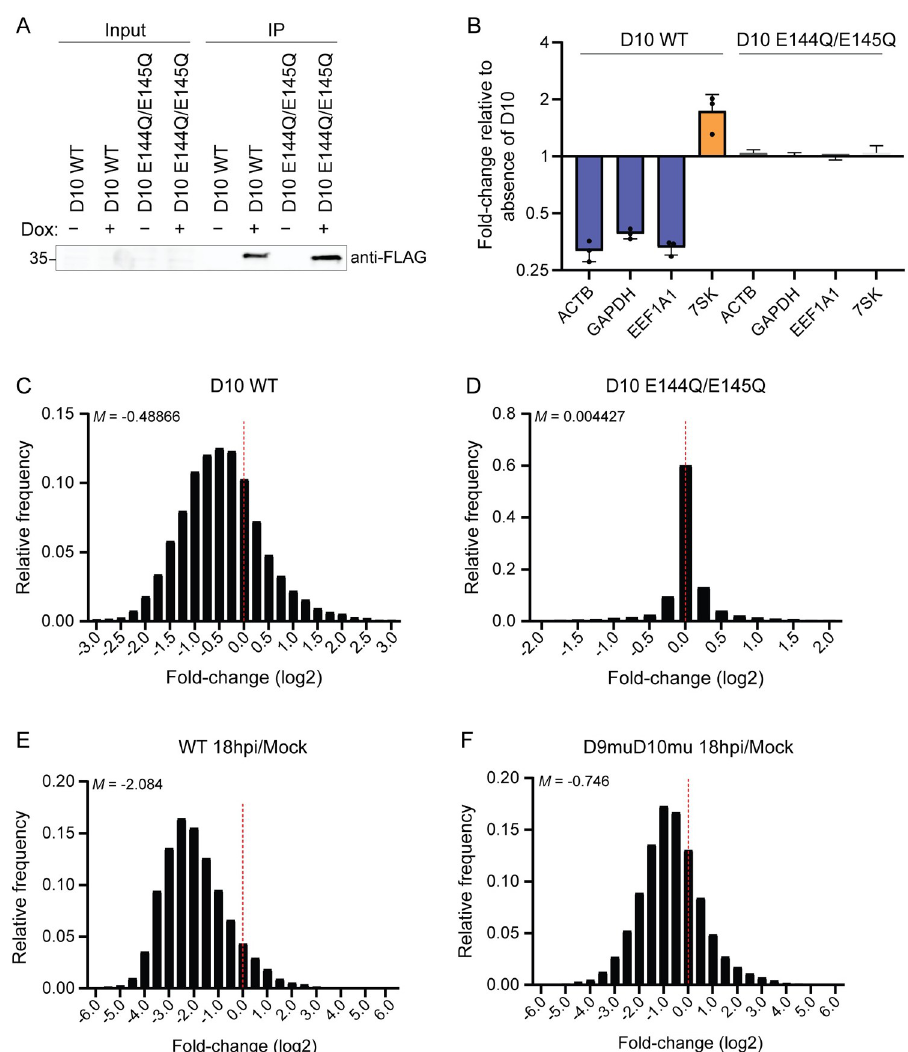
Fig 1. VACV D10 causes global mRNA degradation. (A) Levels of 3xFLAG-D10 WT and E144Q/E145Q were visualized by western blotting following immunoprecipitation with anti-FLAG beads. (B) RT-qPCR was used to measure levels of the indicated RNAs in either uninduced (-) or dox-induced (+) 3xFLAG-D10 WT and E144Q/E145Q HEK293T stable cells. Each point represents an independent replicate (N = 3). The bars represent the mean value of the replicates and error bars represent standard deviation. (C-D) The fold-change value for each host transcript in the 3xFLAG-D10 WT ( C ) and E144Q/E145Q ( D ) was calculated by dividing its expression in the dox-treated condition by its expression in the untreated condition. The frequency distribution for these values is plotted on each histogram. The dotted red line marks the fold-change value of zero, and the median value ( M ) is shown for each plot. (E-F) The fold- change value for each host transcript was calculated by dividing its expression at 18 hpi with either WT VACV ( E ) or D9muD10mu VACV ( F ) by its expression in mock infected cells. The frequency distribution for these values is plotted on each histogram. The dotted red line marks the fold-change value of zero, and the median value ( M ) is shown for each plot. total reads at 18 hpi, consistent with the role of mRNA degradation in shifting the host tran- scriptome to one that is dominated by viral transcripts during infection (S2D Fig). GO term enrichment analyses indicated that, in the D10 induced and WT VACV infection contexts, the most downregulated transcripts included genes involved in oxidative phosphory- lation, as well as ribosomal protein genes (upon D10 induction) and mitochondrial function